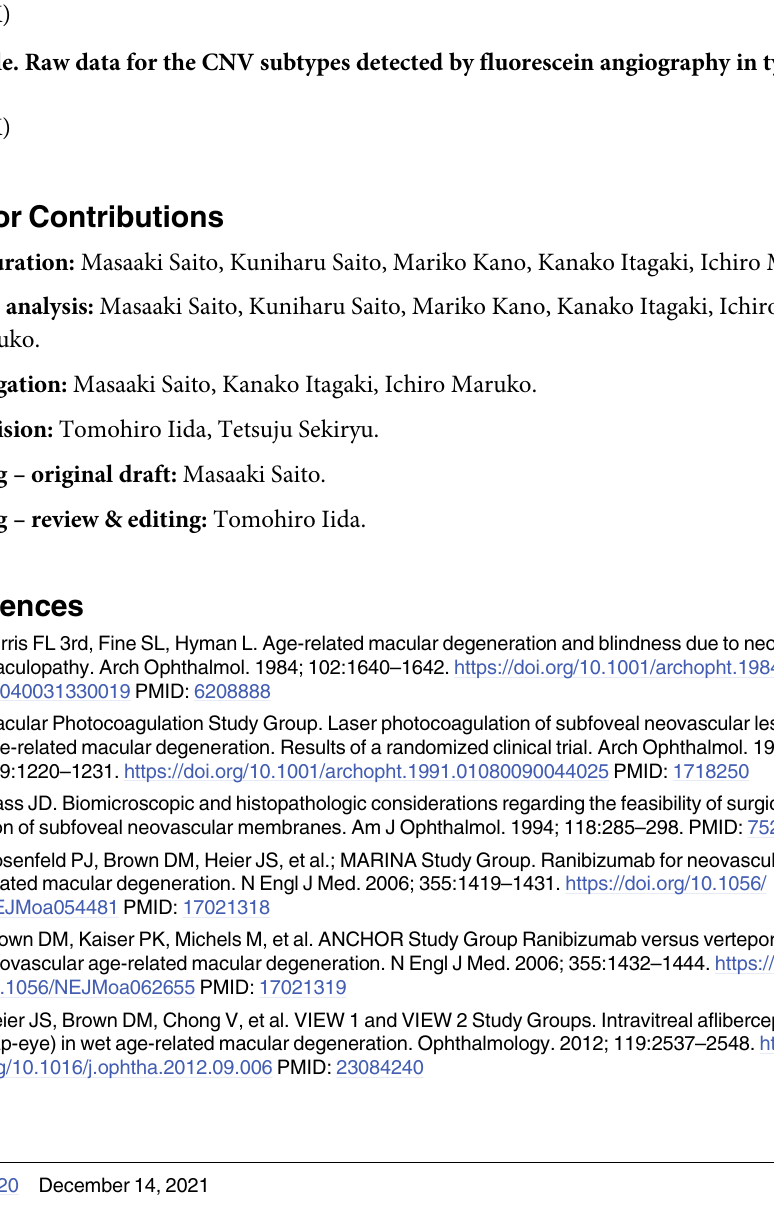
S1 Table. Raw data for the patient characteristics. S2 Table. Raw data for the CNV subtypes detected by fluorescein angiography in typical